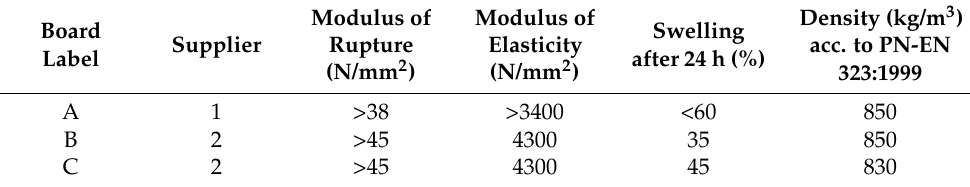
Table 1. Basic information on the boards